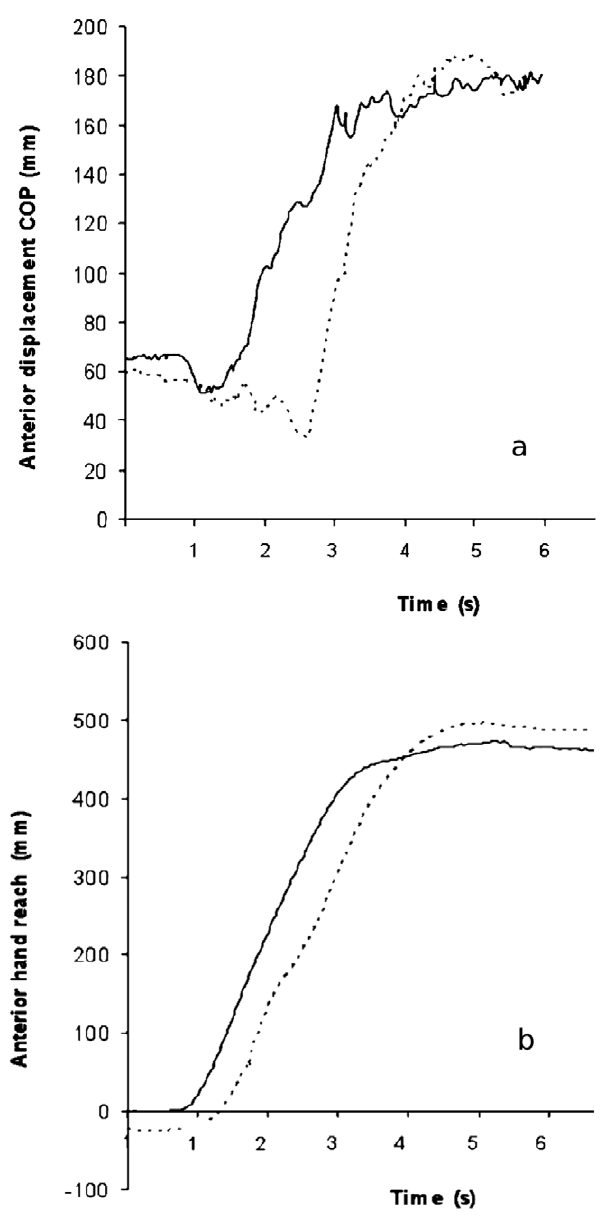
Figure 2. Traces of the anterior displacement of the COP and dominant hand. Traces of the anterior displacement of the COP (a) in no touch (solid line) and light touch conditions and traces of foreword movements of the dominant hand. (b) Trace of hand anterior displacement during reaching movement in no touch (solid line) and light touch conditions (dotted